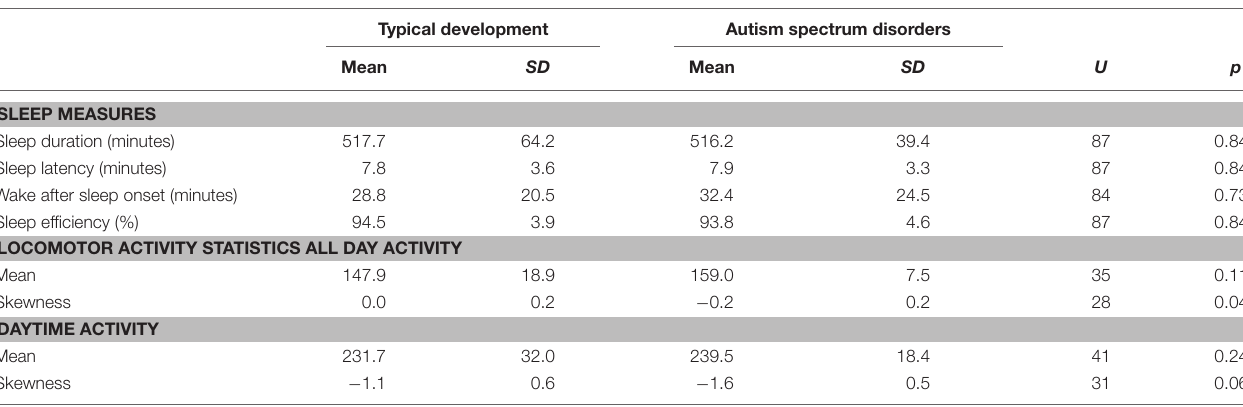
TABLE 2 | Locomotor dynamics.